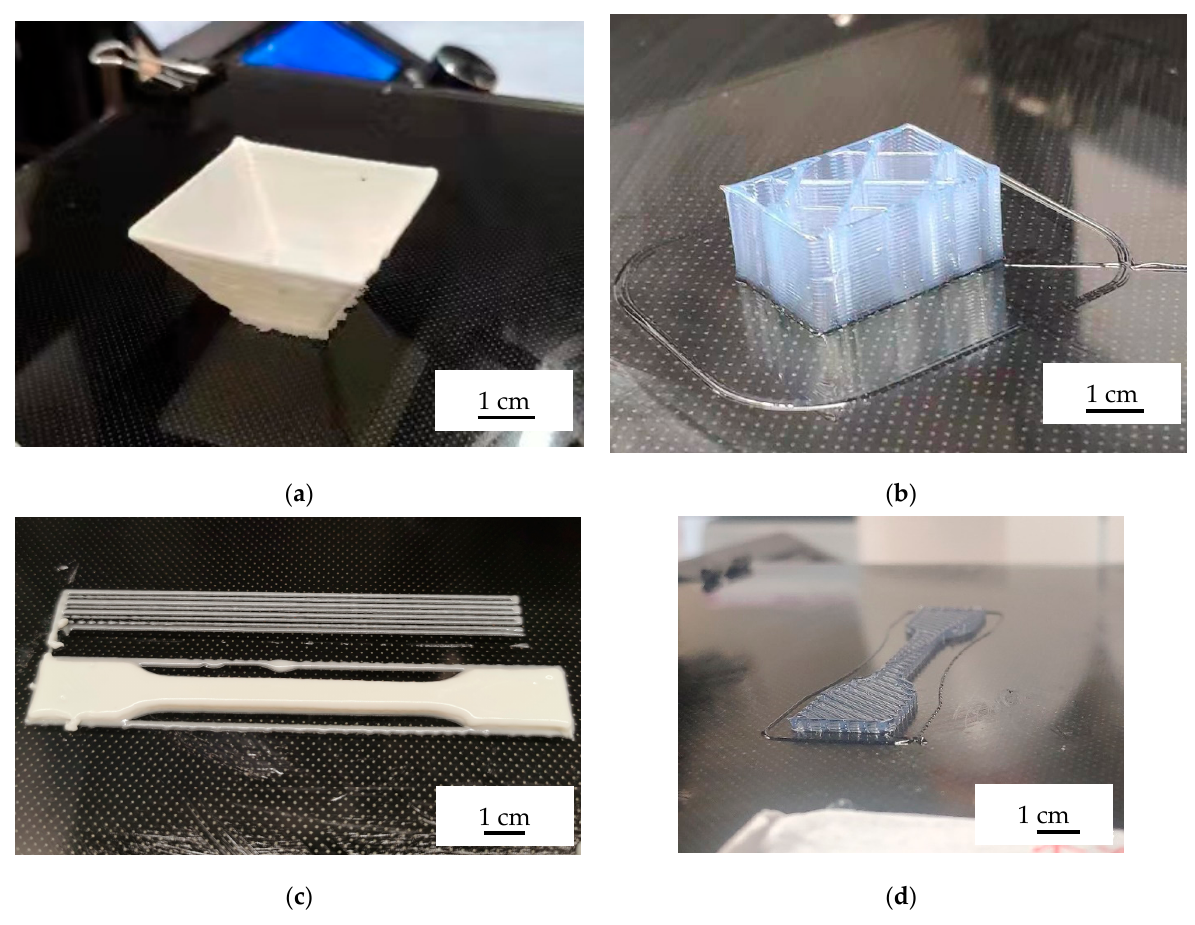
Figure 9. ( a ) 45 − degree square frustum; ( b ) cube with reinforcement ribs; ( c ) solid − filled tensile bar; ( d ) hollow tensile bar with 45° crossover directions.